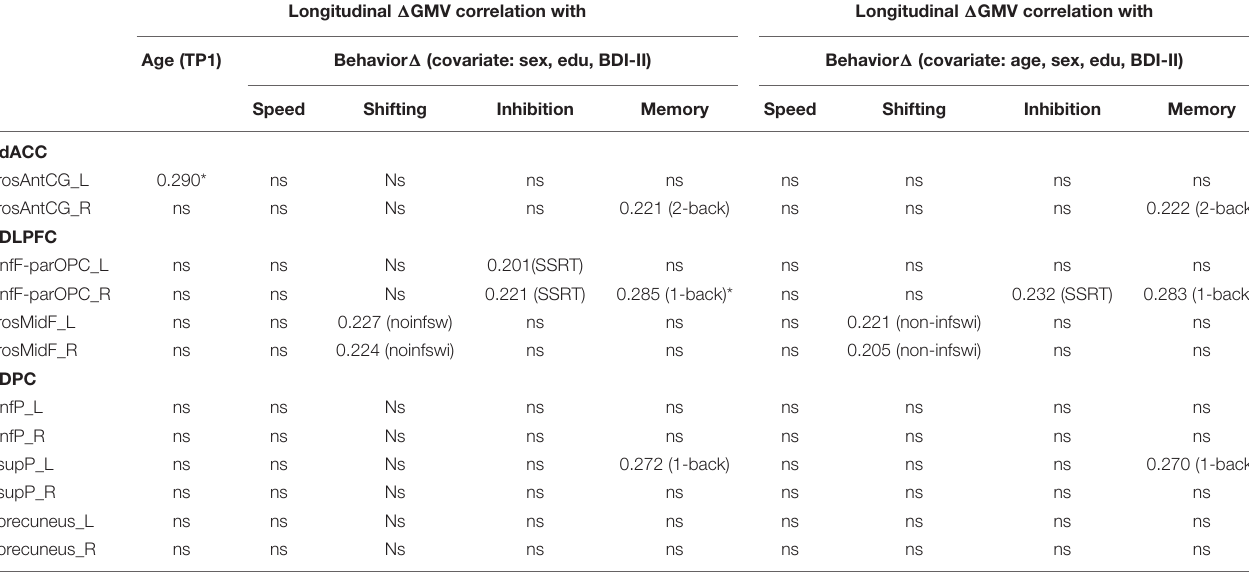
TABLE 6 | Longitudinal correlation table ( n = 102). Longitudinal (cid:49) GMV correlation with Longitudinal (cid:49) GMV correlation with Age (TP1) Behavior (cid:49) (covariate: sex, edu, BDI-II) Behavior (cid:49) (covariate: age, sex, edu,